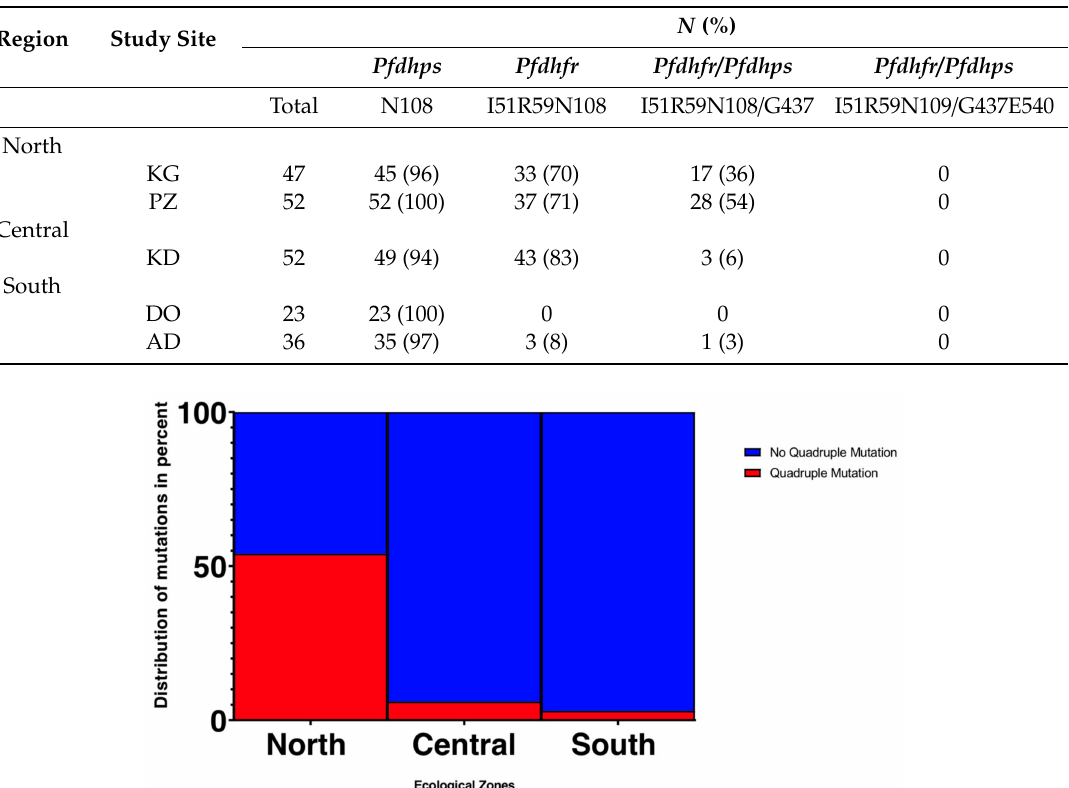
Table 4. Haplotype prevalence of mutations in the pfdhfr codons N51I, C59R, S108N, and pfdhps A437G and K540E present among the P. falciparum isolates from three regions in Ghana. N denoted the total number of successfully amplified samples. Percentages (%) were presented in parentheses.